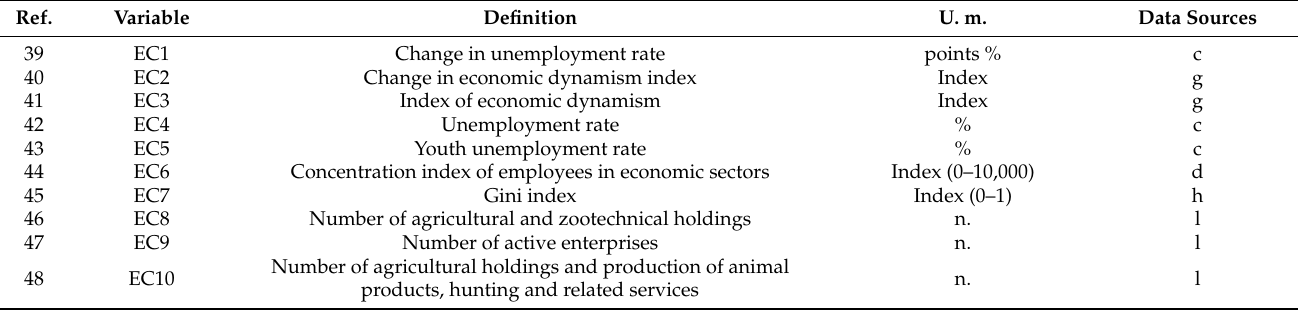
Table 3. Economic capital